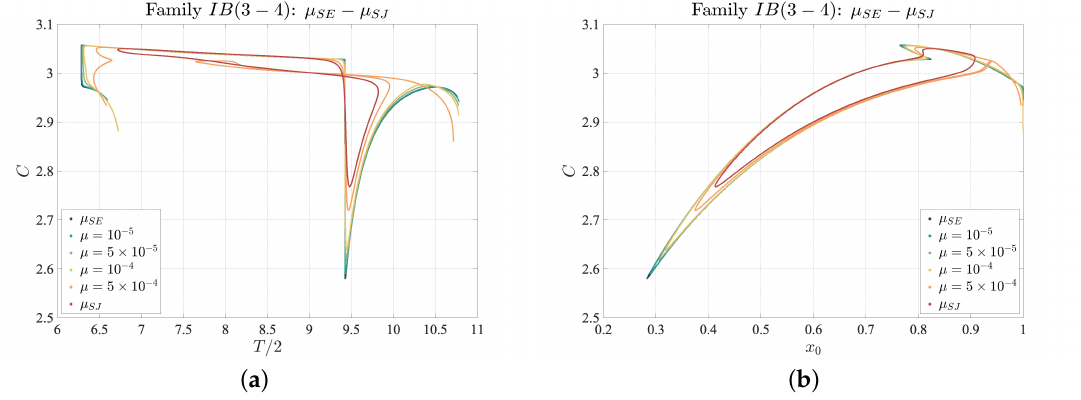
Figure 6. Characteristic curves of the family IB ( 3 − 4 ) continued from the Sun–Earth system ( µ SE ) to the Sun–Jupiter system ( µ SJ ). ( a ) Family IB ( 3 − 4 ) shown in the T − C plane; ( b ) family IB ( 3 − 4 ) shown in the x 0 − C plane. T /2 is half the orbital period in the synodic frame. C is the Jacobi constant. x 0 is the initial state of the periodic orbits on the x -axis. Different colors indicate different mass